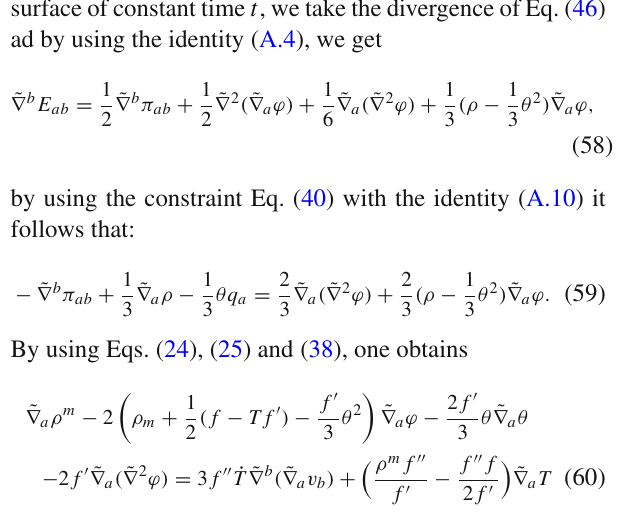
which is the second integrability condition, The left and right hand sides of Eq. (60) refer to GR and non-GR